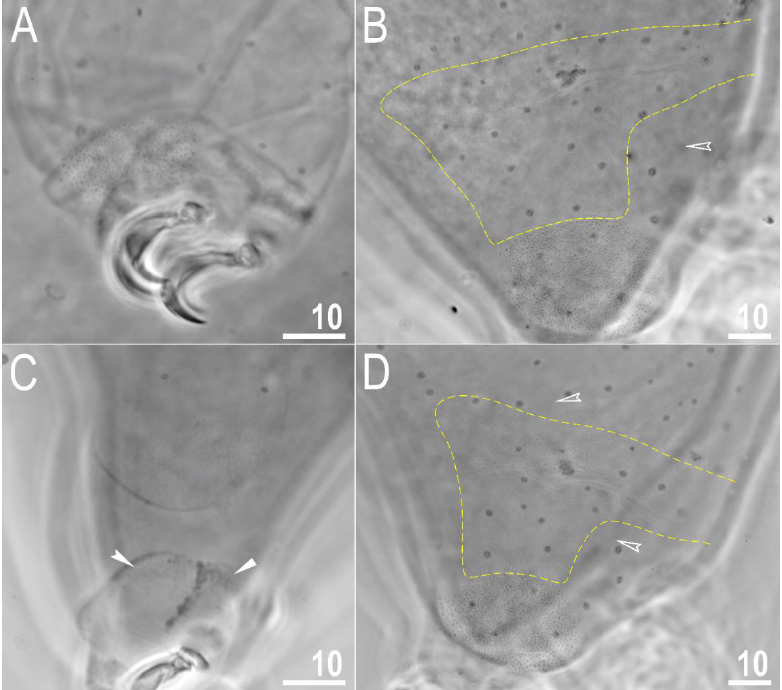
Figure 2. Macrobiotus rebecchii sp. nov. PCM images of leg and body granulation: ( A ) granulation on the external surface of leg III (paratype); ( B ) granulation on the hind leg and a band of sparse granulation seen in the caudal region of the last body segment (paratype); ( C ) a pulvinus-shaped cuticular bulge on the internal surface of leg II and an additional cuticular fold positioned distally (holotype); ( D ) granulation on the hind leg and a band of sparse granulation seen in the caudal region of the last body segment (paratype). The filled flat arrowhead indicates a single continuous cuticular bar above the claws, the filled indented arrowhead indicates an additional cuticular fold on the internal leg surface, and the empty indented arrowheads indicate body granulation faintly visible in PCM in the proximity of the well-visible caudal band of granulation, which is marked by a yellow dashed line. Scale bars in µ